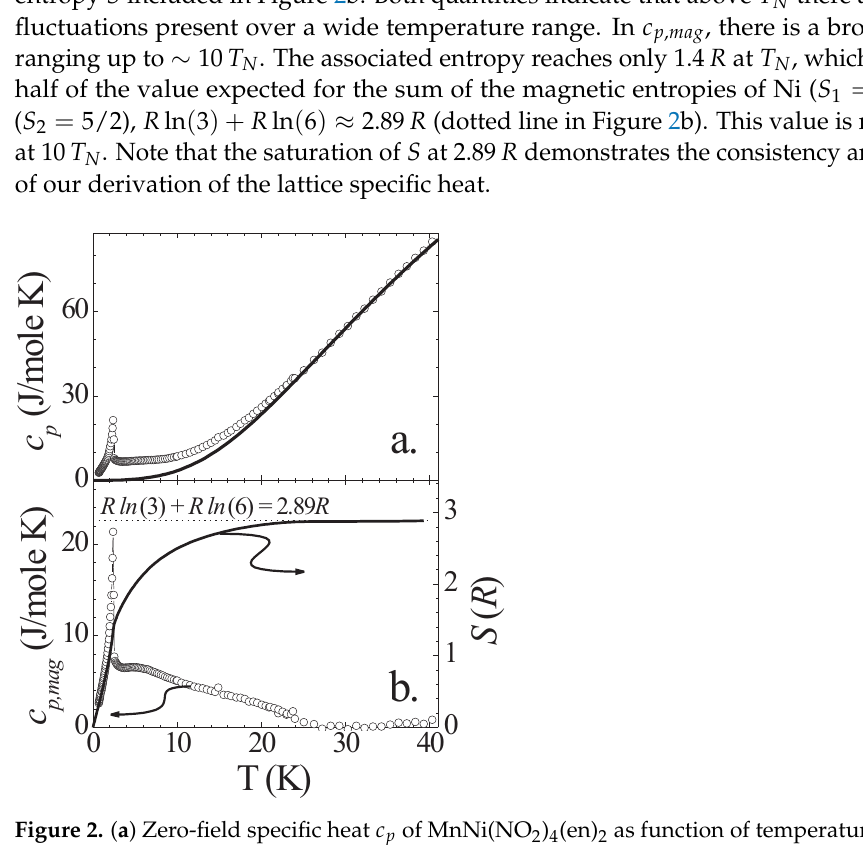
Figure 2. ( a ) Zero-field specific heat c p of MnNi(NO 2 ) 4 (en) 2 as function of temperature T . ( b ) Zero- field magnetic specific heat c p , mag and associated entropy S per mole of MnNi(NO 2 ) 4 (en) 2 as function of